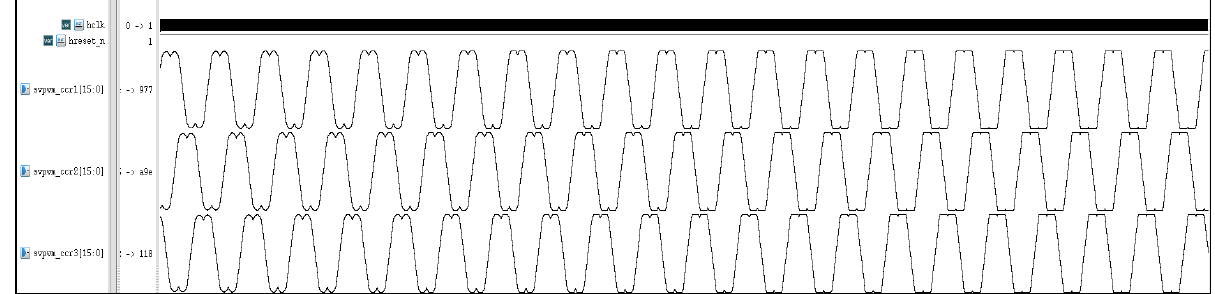
Figure 12. Hardware implementation simulation of overmodulation algorithm.